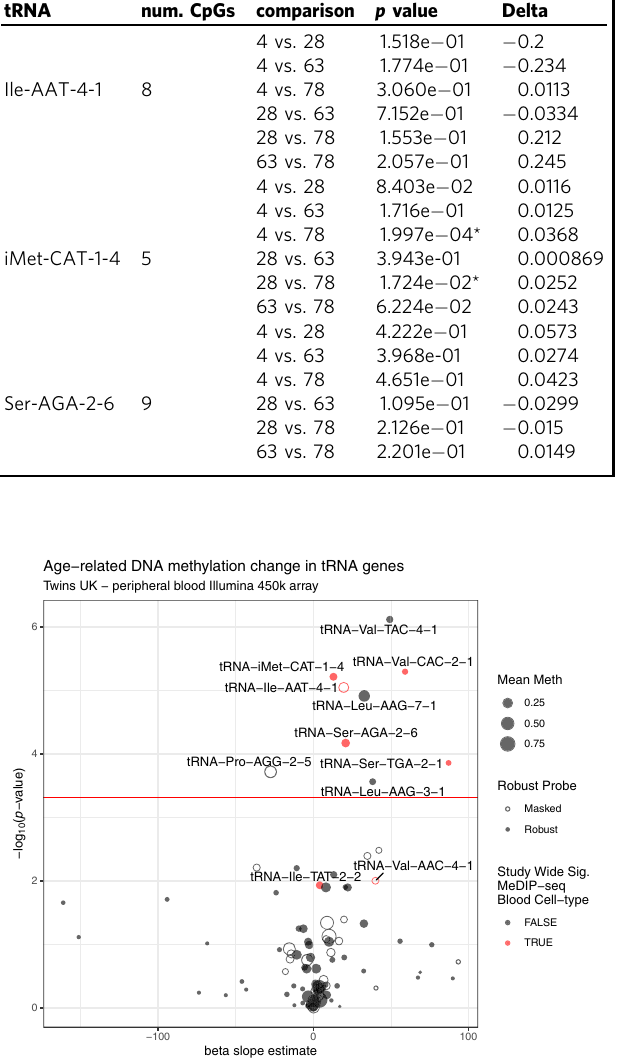
Fig. 6 Age-related DNA methylation change in tRNA genes A. Five of seven tRNAs study-wide signi fi cant in MeDIP covered by the 450k array also show signi fi cant hypermethylation in these data. tRNAs are labelled if they are signi fi cant here or were in the MeDIP-seq data (Red). Model slope: the model coef fi cient for the methylation values. Un fi lled circles indicate those probes with potential issues generated by Zhou et al. 42 this includes tRNA-Ile-AAT-4-1. Signi fi cance threshold: 0.05/103 ≈ 4.58 × 10 − 4 (the number of tRNA genes examined). Source data are provided as a Source Data fi le. beta = proportion